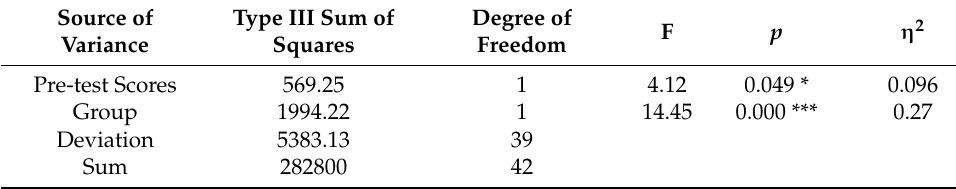
Table 6. ANCOVA results on learning effectiveness between the two groups. Source of Type III Sum of Degree of Variance Squares Pre-test Scores